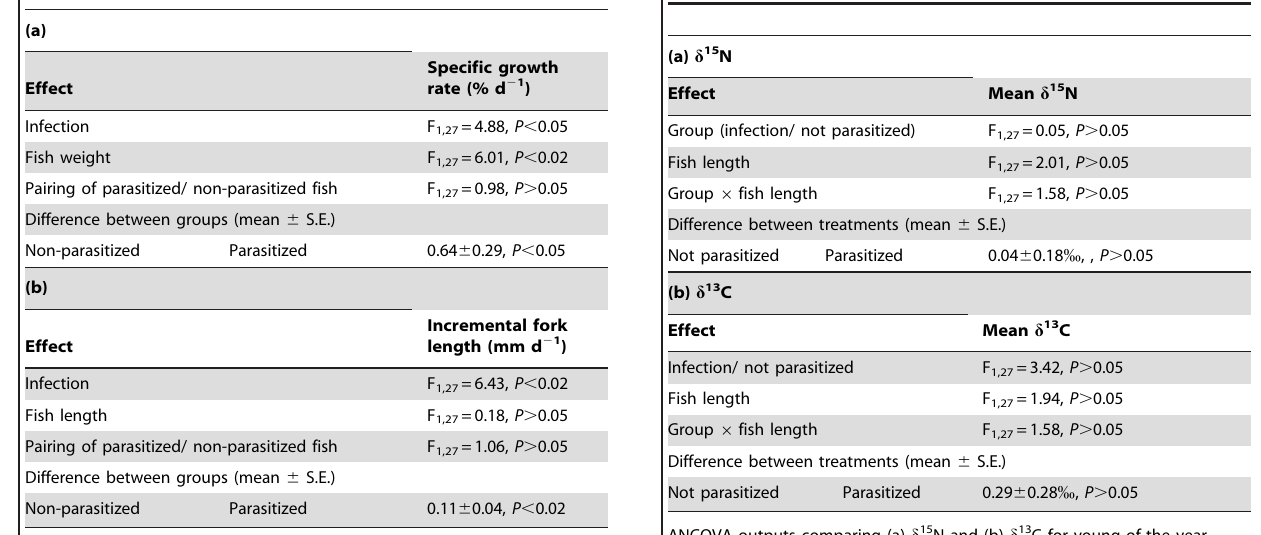
Table 5. Stable isotope analysis of Cyprinus carpio infected with Bothriocephalus acheilognathi and held in controlled